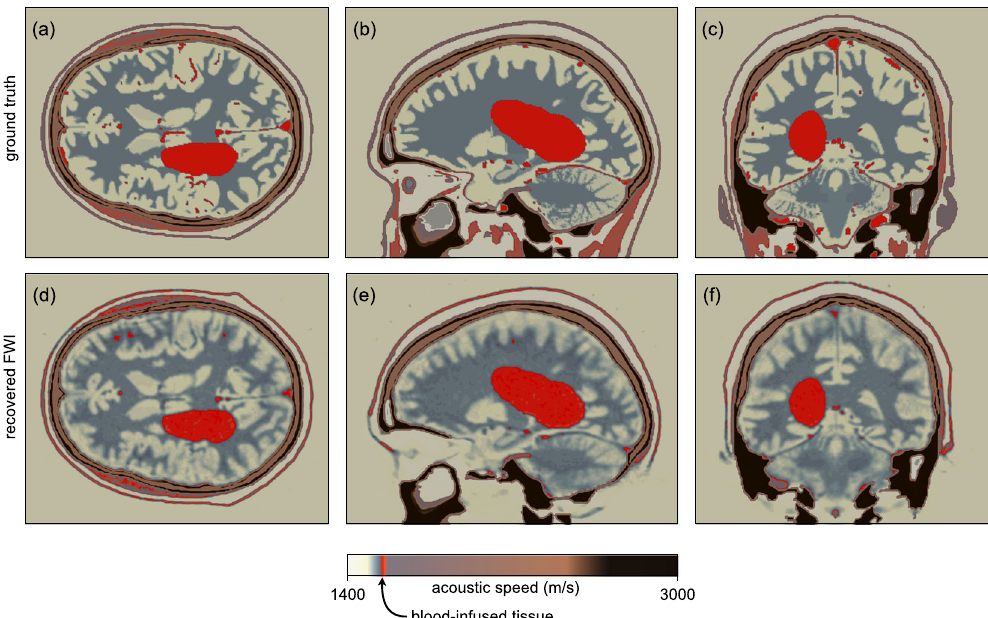
Fig. 8 Recovery of a large haemorrhage by FWI. a – c Slices through a 3D wave-speed model perturbed by a large haemorrhage. d – f The same slices through the FWI. The haemorrhage is well recovered by full-waveform inversion at high resolution in all slices. The colour scale has been modi fi ed to highlight the